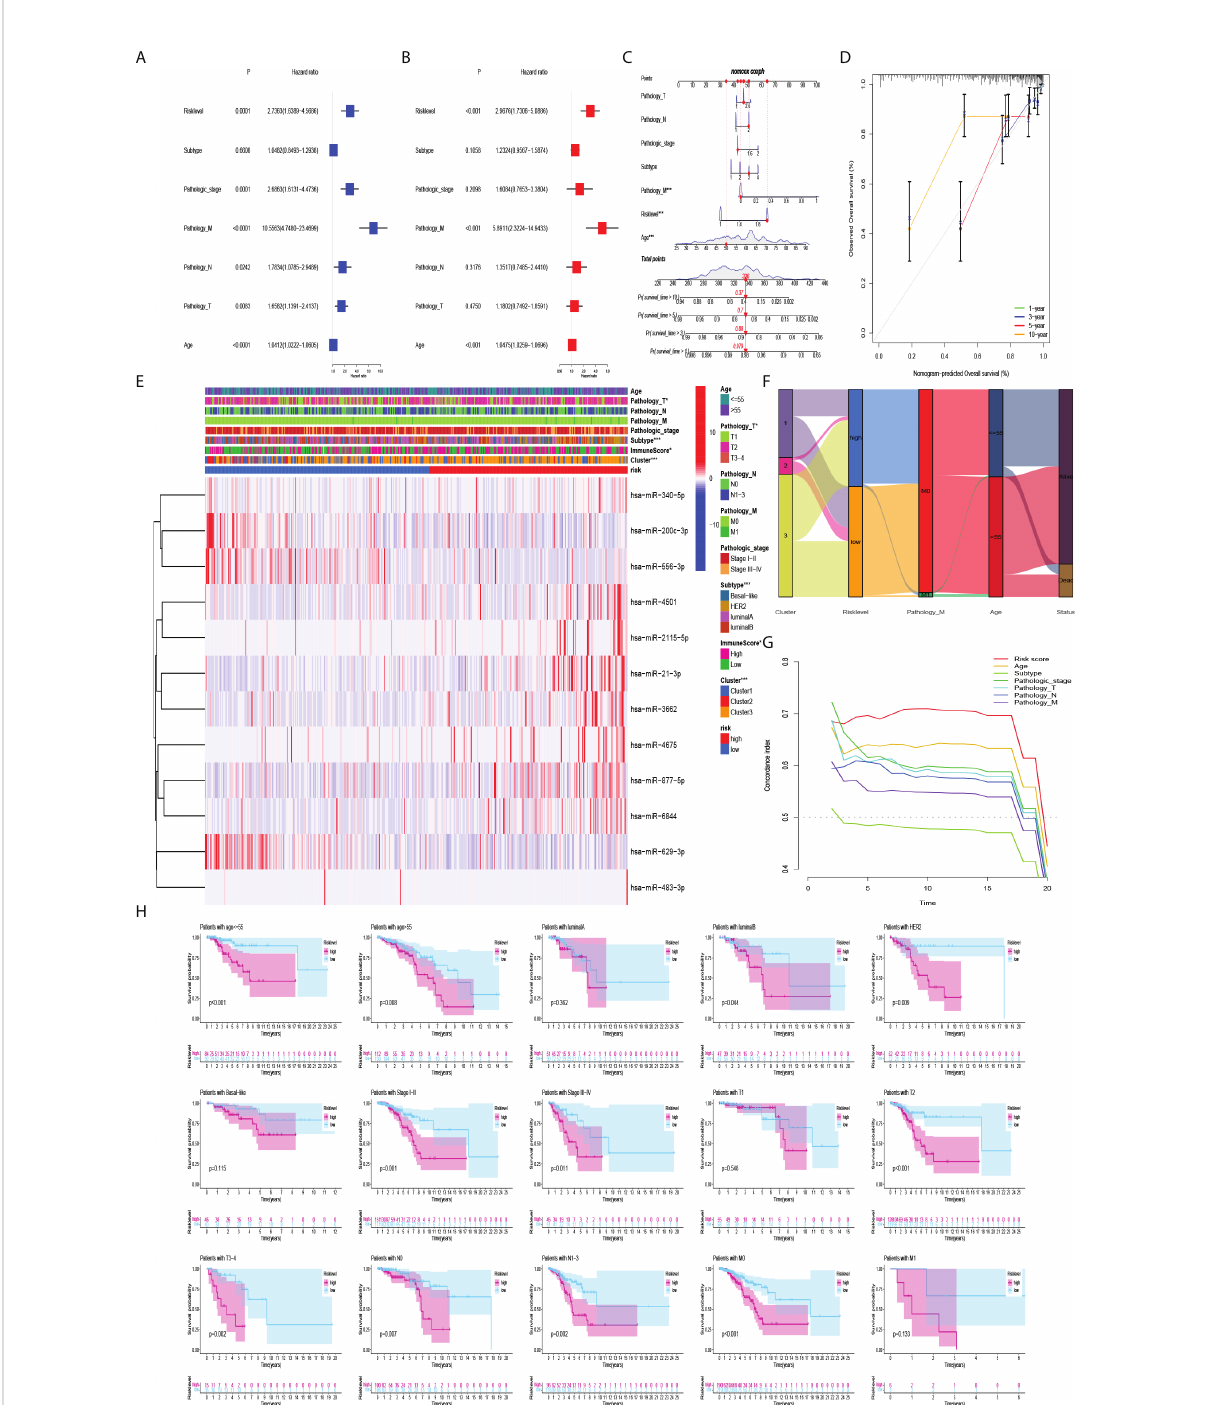
FIGURE 6 Association of model and clinicopathological features. (A) Univariate Cox regression analysis and (B) multivariate Cox regression analysis showed that risk level was an independent prognostic risk factor. (C) Nomogram of risk level and clinicopathological features for one of the patients. (D) Plot of the prediction model calibration curve. (E – G) Heatmaps, sankey diagram, and C-index for model and clinicopathological features. (H) Kaplan-Meier curves of the risk model in clinical